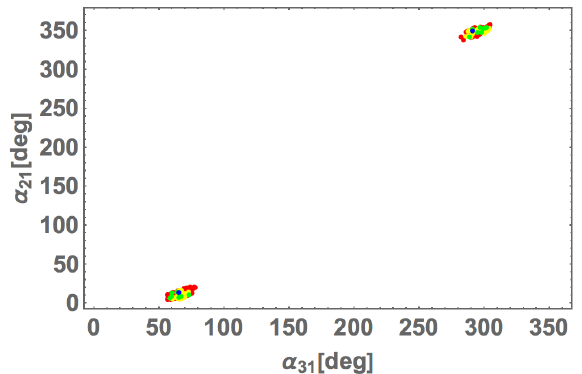
Figure 4 . Allowed region of Majorana phases α 21 and α 31 , where the color legends are the same as the one in figure 1.